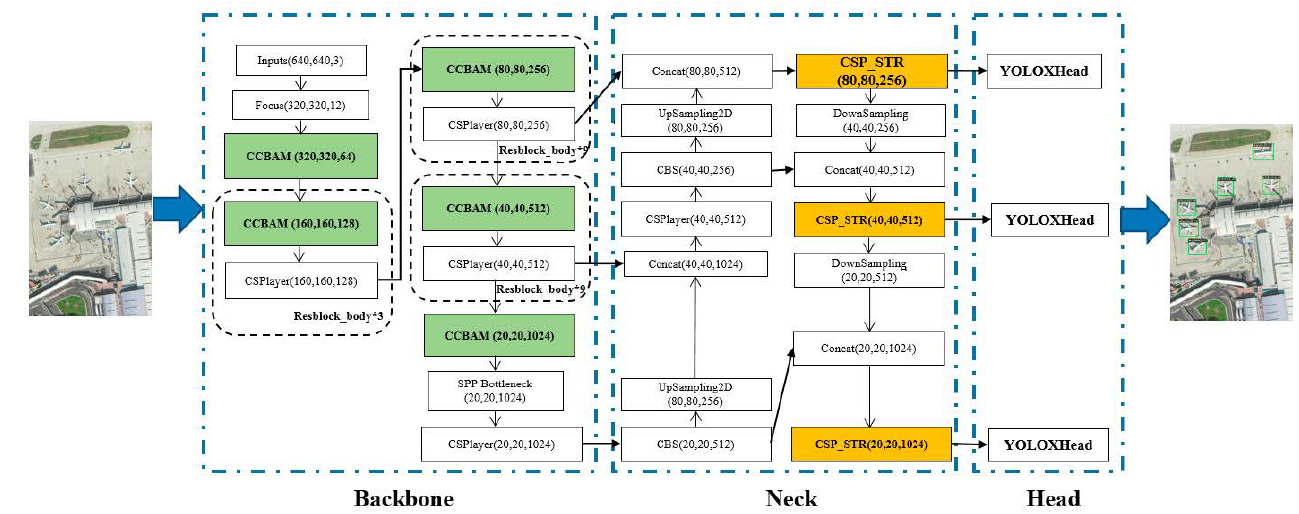
Figure 4. The architecture of the improved YOLOX.